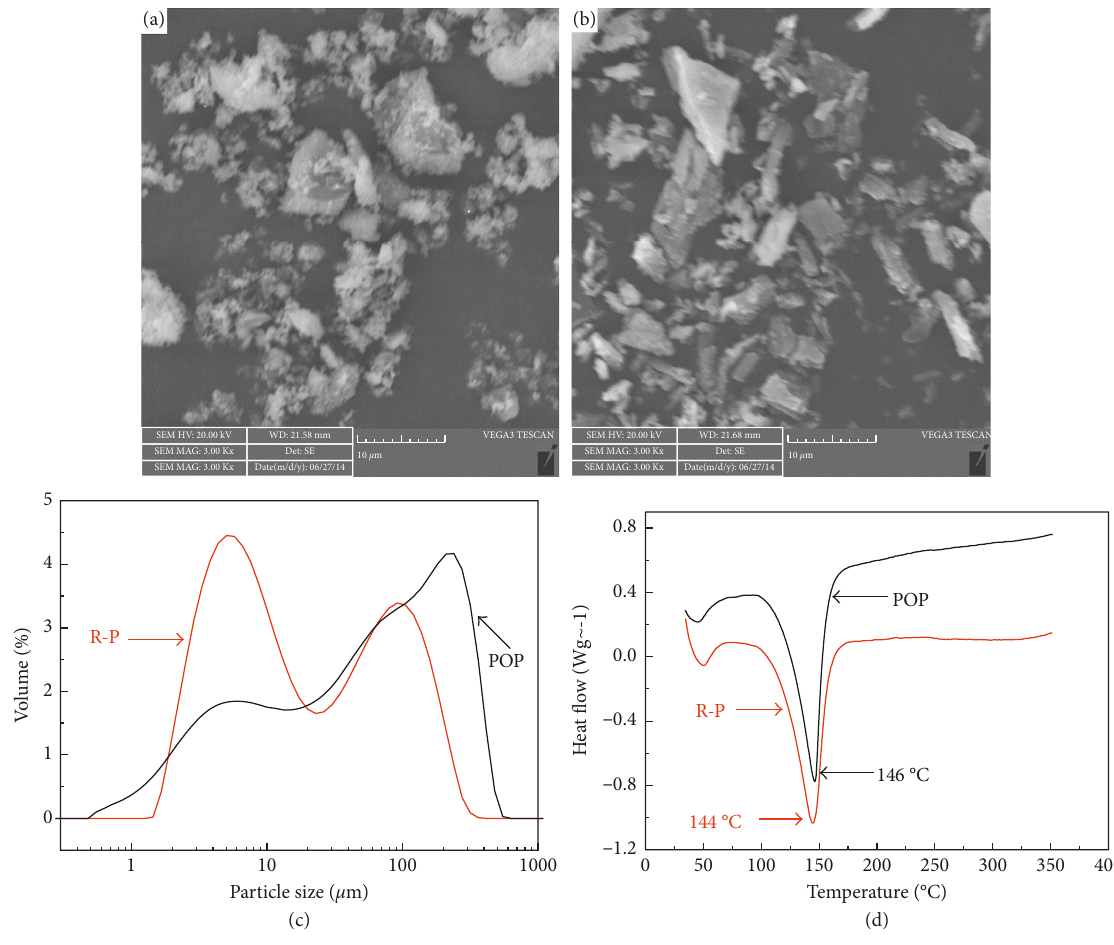
Figure 5: Microstructure, particle size distribution, and DSC curves of POP and R-P.